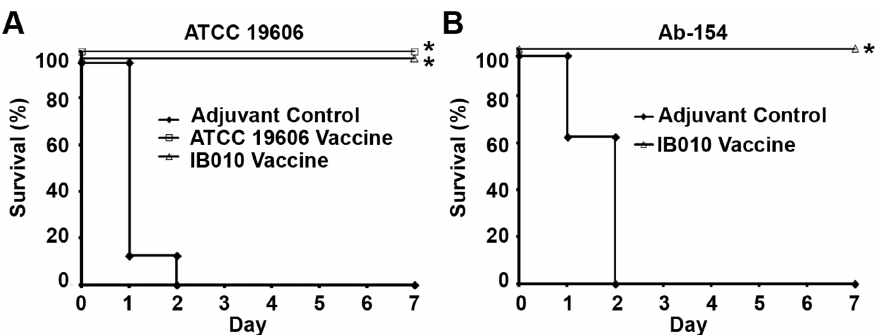
Figure 5. Effect of vaccination on survival in a mouse model of disseminated A. baumannii infection. Vaccinated and control mice were infected with 2.25 6 10 6 cfu (340.9 6 LD 50 ) of the ATCC 19606 strain (A) or 1.05 6 10 6 cfu (2.18 6 LD 50 ) of the A. baumannii clinical isolate Ab-154 (B), and survival was monitored over the following 7 days (n 5 8 mice/group). * p , 0.05 compared to control mice.